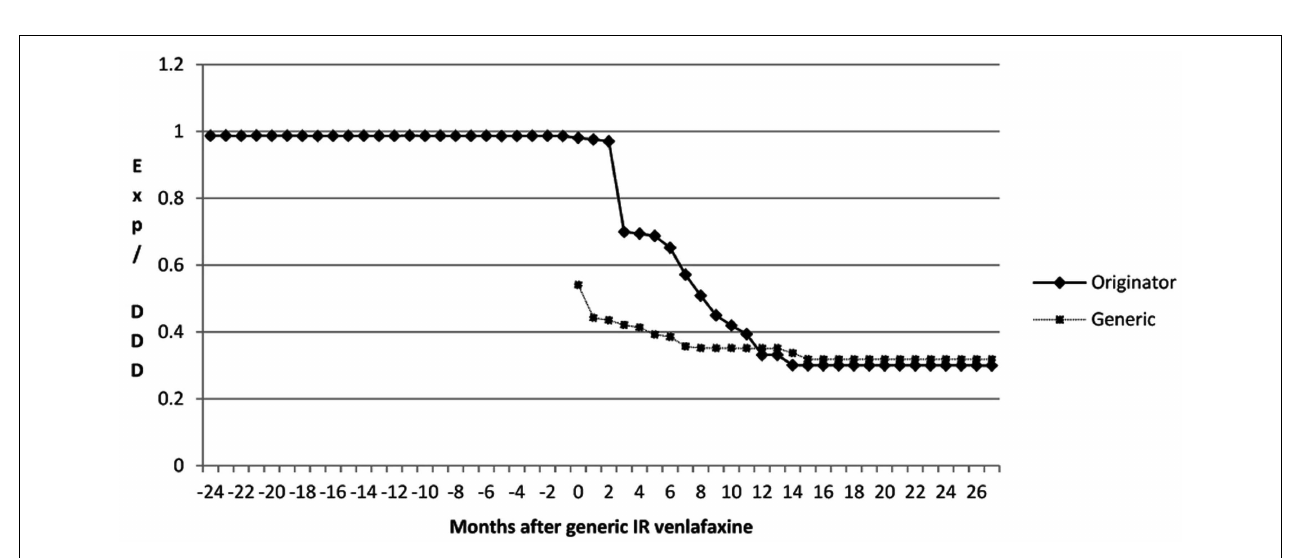
FIGURE 3 |Total expenditure/DDD for venlafaxine IR over time